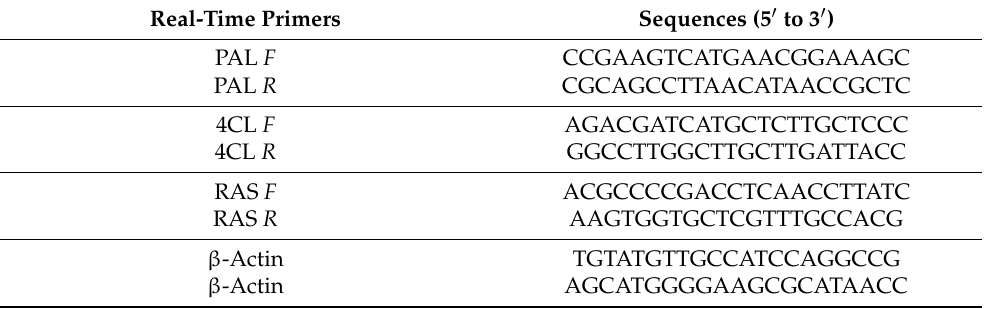
Table 1. Primers used to qRT-PCR